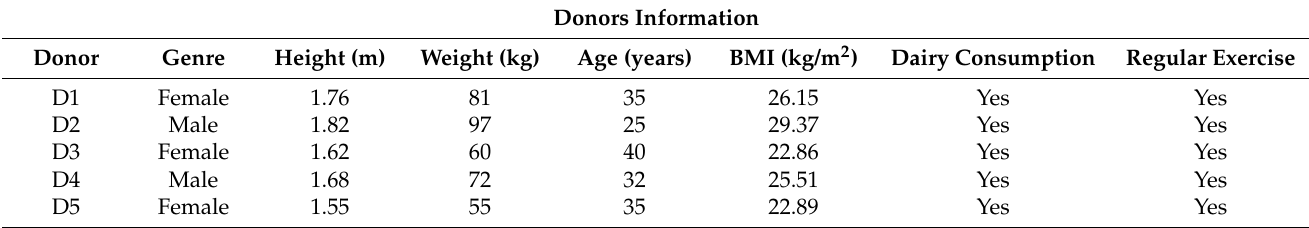
Table 1. Volunteer Detailed